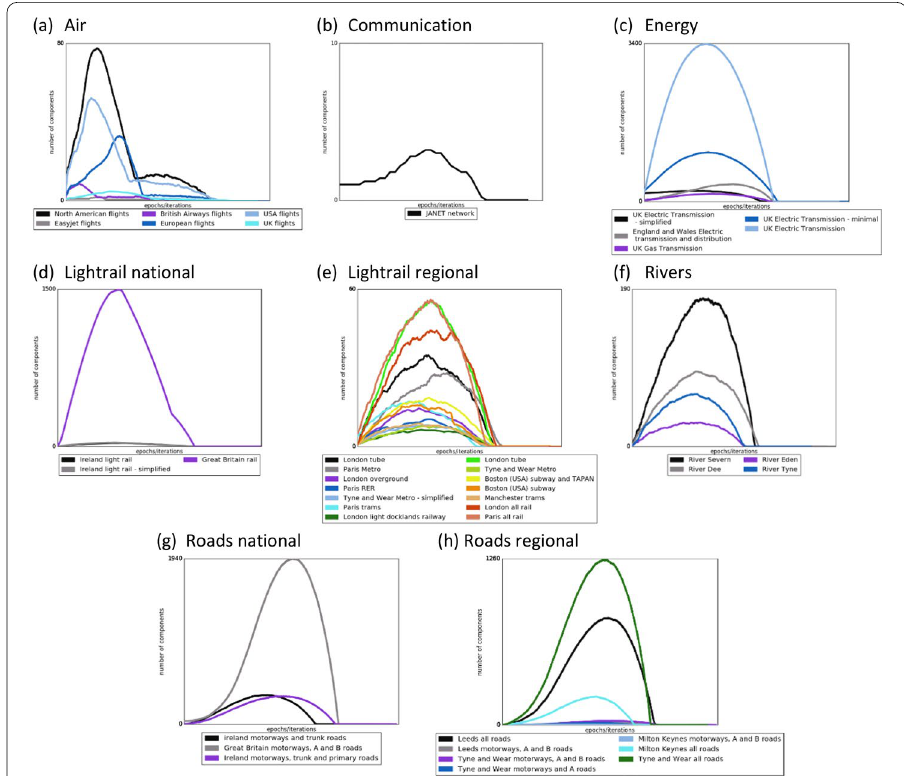
the number of components and the x-axis shows the % of nodes removed from the graph, with a more robust network showing a smaller peak and towards the left of the